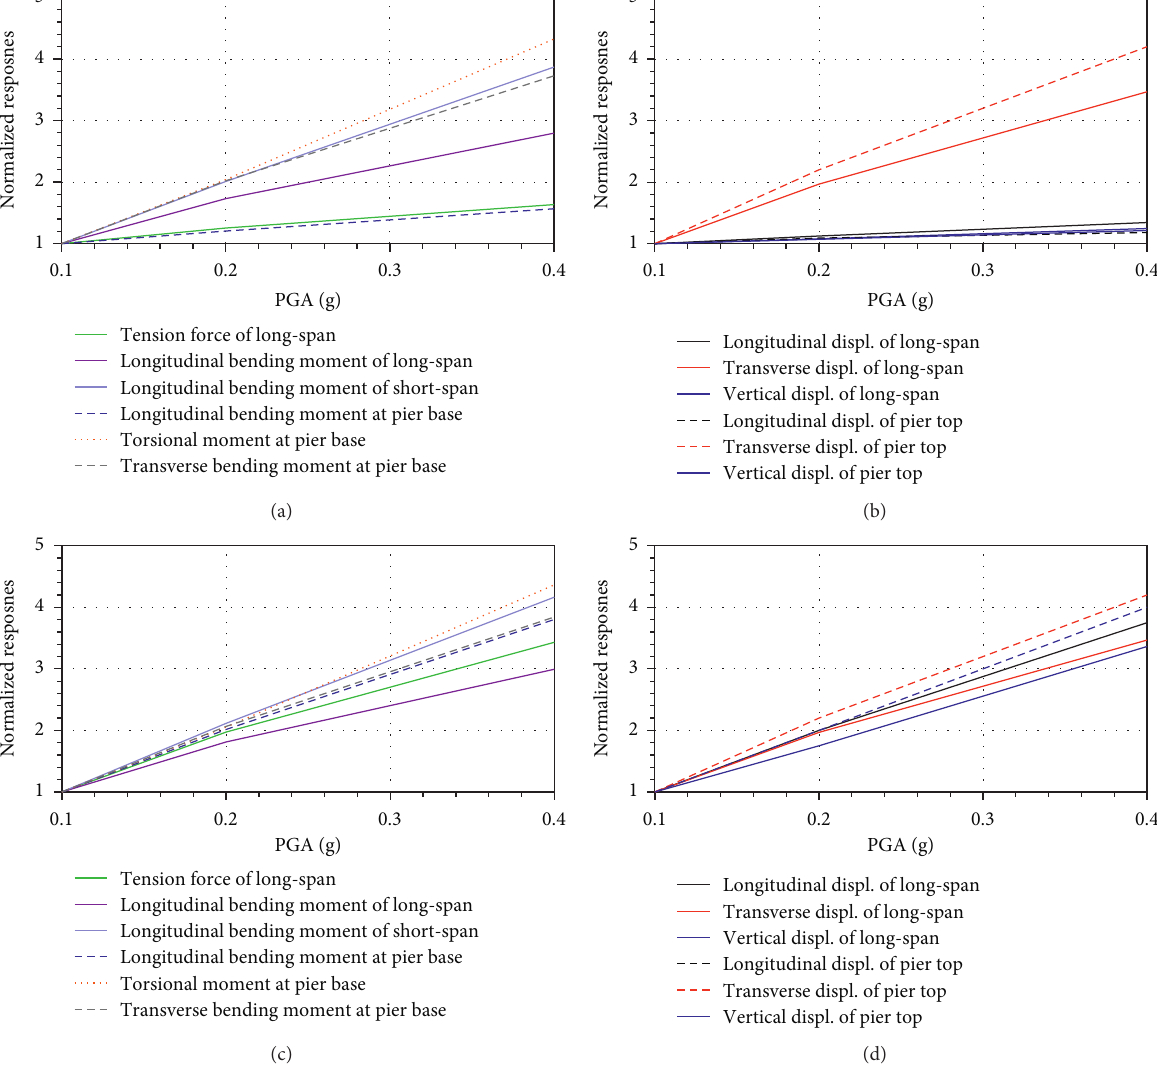
Figure 7: Responses varied with the intensity of ground motions. (a) The force responses considering self-weight. (b) The displacement response considering self-weight. (c) The force responses excluding self-weight. (d) The displacement response excluding